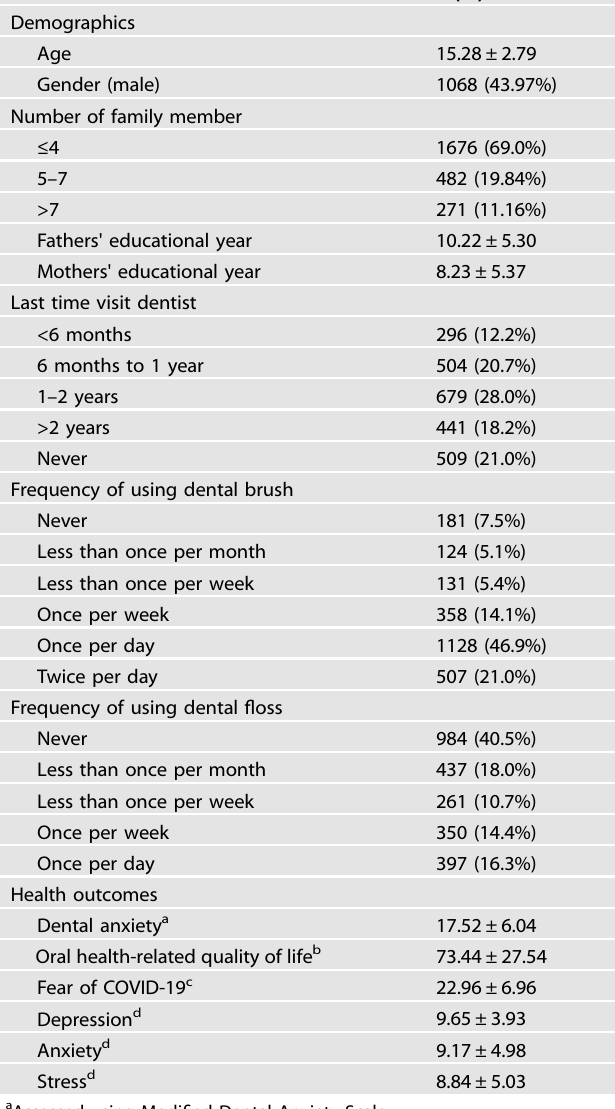
Table 1. Participants characteristics (N =